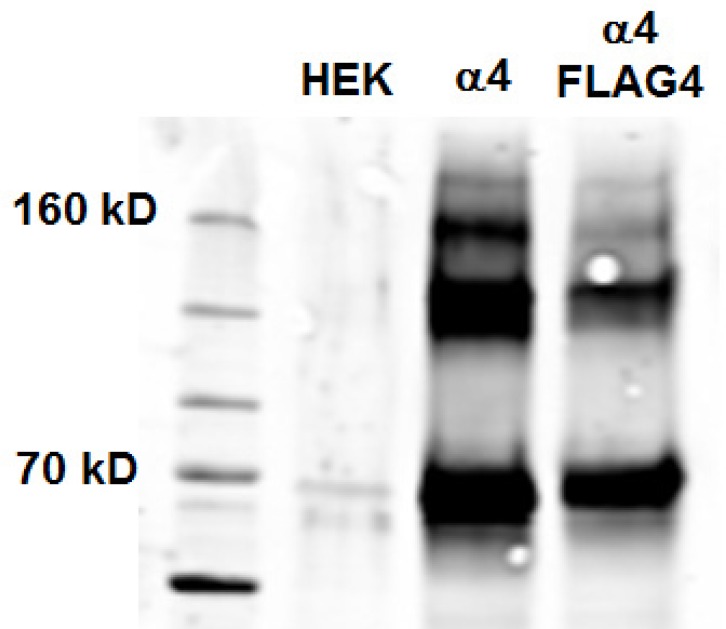
Immunoblot comparing total expression of α4 immunoreactive material between α4β4 receptors and α4FLAG4β4 receptors.The figure shows a molecular weight ladder (1st lane), then protein from untransfected HEK cells (“HEK”), from cells transfected with α4 and β4 subunits (“α4”) and from cells transfected with α4FLAG4 and β4 subunits (“α4FLAG4”). The α4 subunit was detected using an antibody against the cytoplasmic loop. Quantitation of the bands at about 70 kD reveals a modest decrease in the α4 FLAG β4 receptor compared to wild type (to 74% of wild-type). The α4 subunit is expected to migrate with an apparent molecular weight of about 67 kD. The more slowly migrating, likely aggregated, material showed a similar reduction, to 73% of wild type.